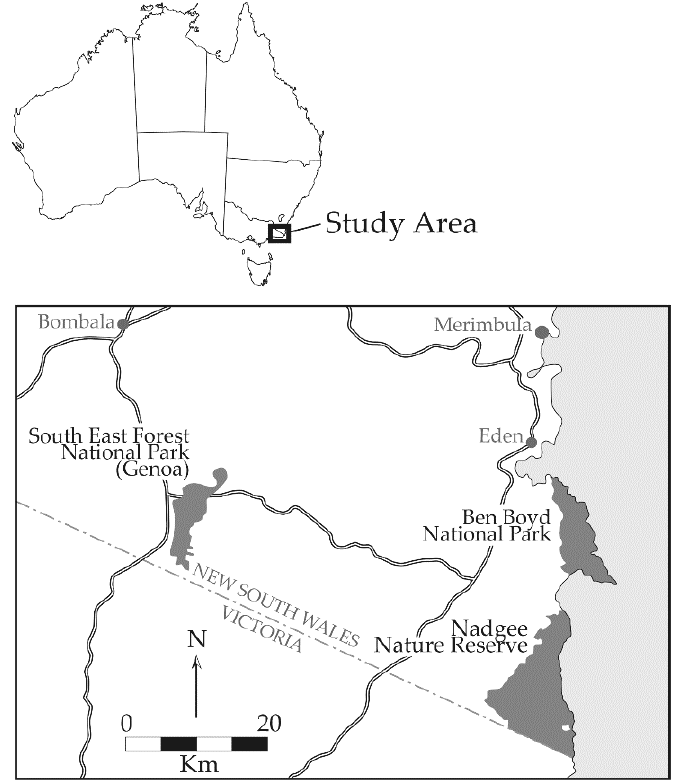
Figure 2. Map of the general study area in south-eastern New South Wales, Australia.